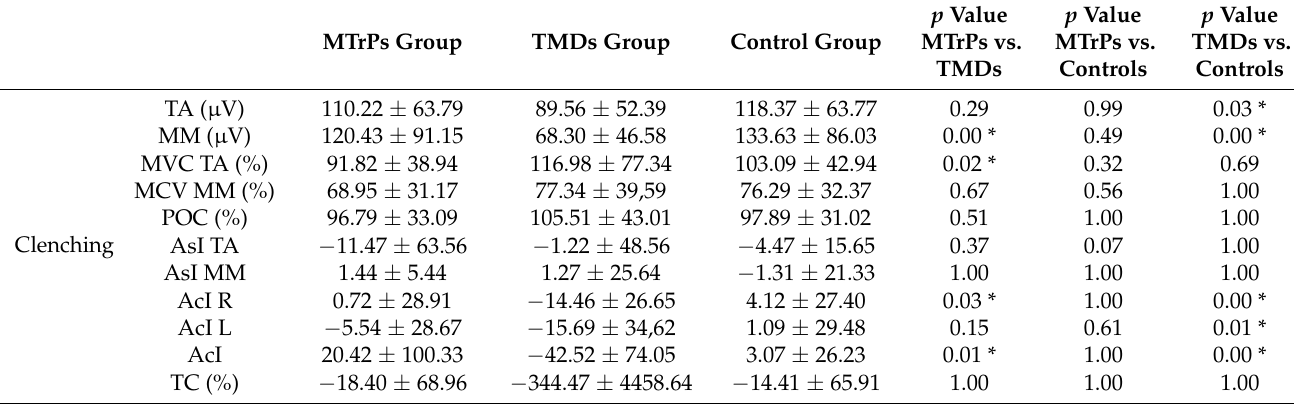
Table 4. Comparison of the mean values ( ± SD) of bioelectric activity of temporalis anterior (TA), masseter muscle (MM) and electromyographic indices between groups during